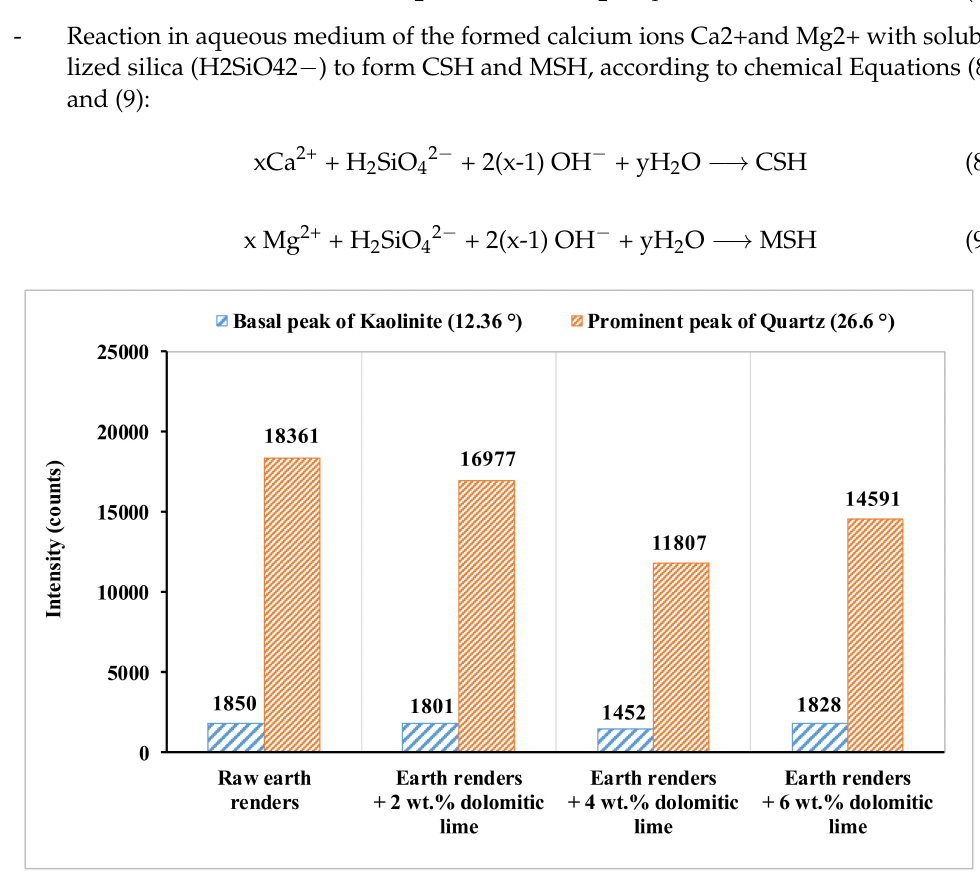
Figure 7. Evolution of the kaolinite basal and prominent quartz peaks versus dolomitic lime.